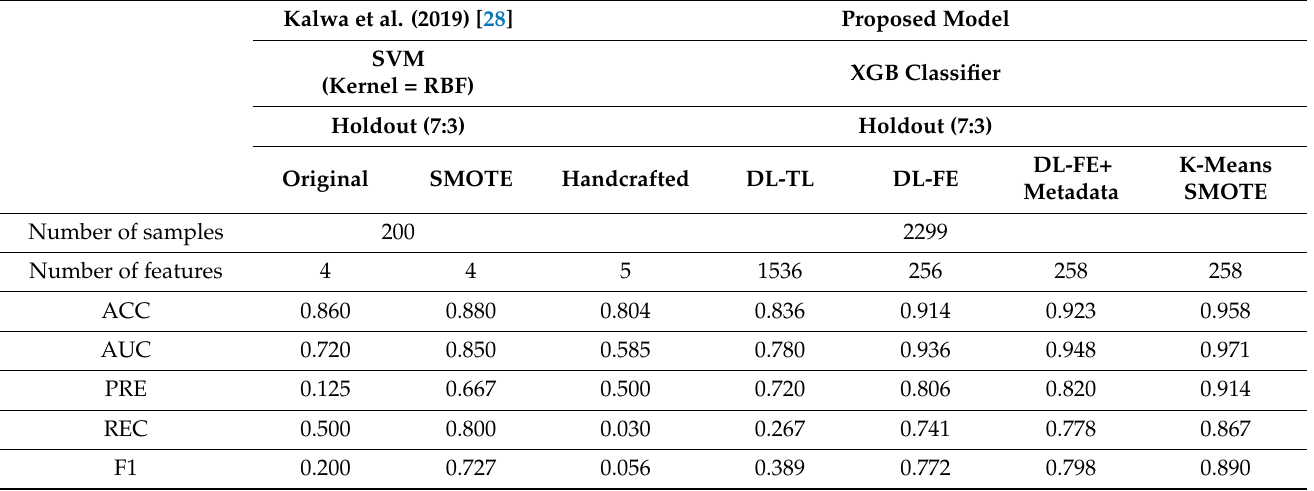
Table 12. Performance comparison with Kalwa et al. [28].